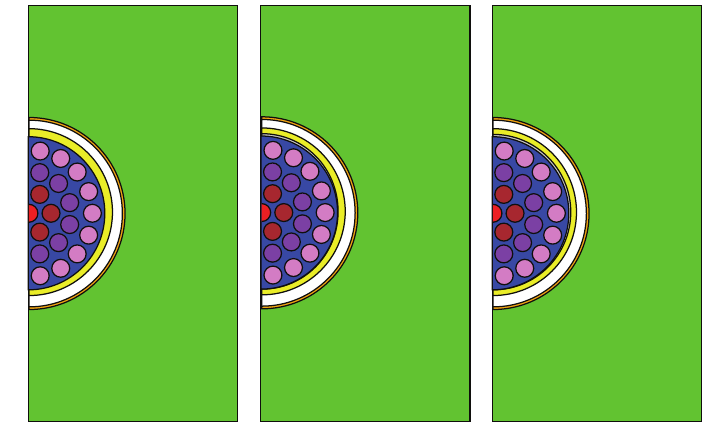
Figure 2: Geometry modelling.